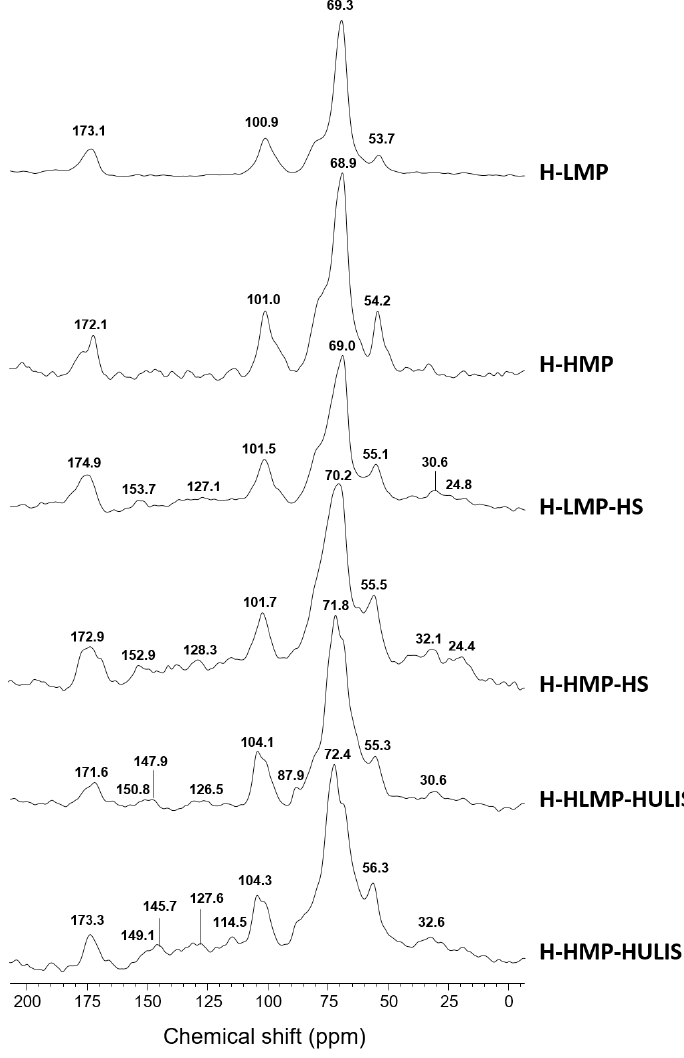
Figure 1. 13 C CPMAS NMR spectra of hydrogels based on low methyl-esterified pectin (H-LMP), high methyl-esterified pectin (H-HMP), or on their combination with either humic substances extracted from cow manure compost (H-LMP-HS and H-HMP-HS) or humic-like substances from depolymerized lignocellulose biorefinery residues (H-LMP-HULIS and H-HMP-HULIS).